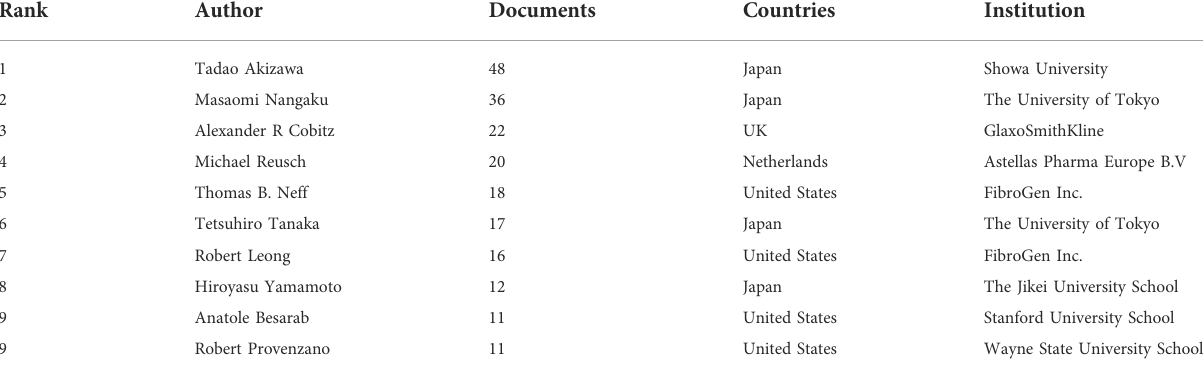
TABLE 1 Nationality and working place of the top 10 high-productive authors.